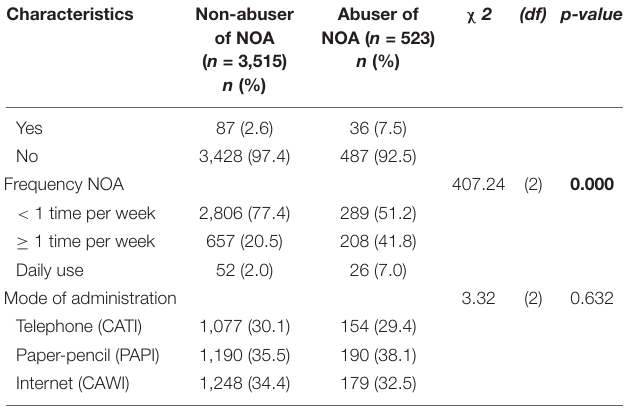
TABLE 3 | Multiple logistic regression model for factors associated with NOA abuse among user of NOA ( n =